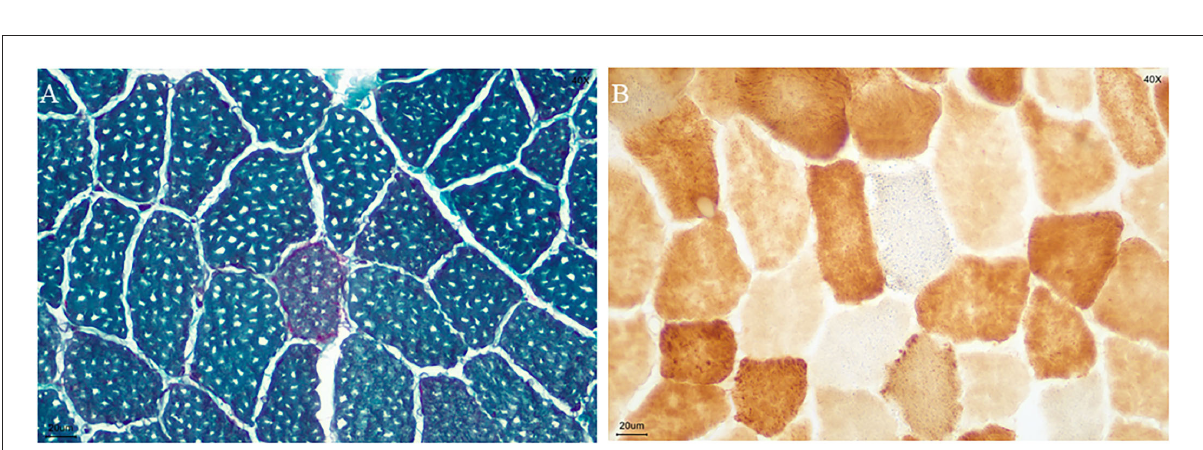
FIGURE2 Biopsy specimen. (A) ragged red fibers (MGT staining ) ; (B) COX-negative and SDH-positive fibers in blue (COX/SDH double staining) (bar = 20 µ m).